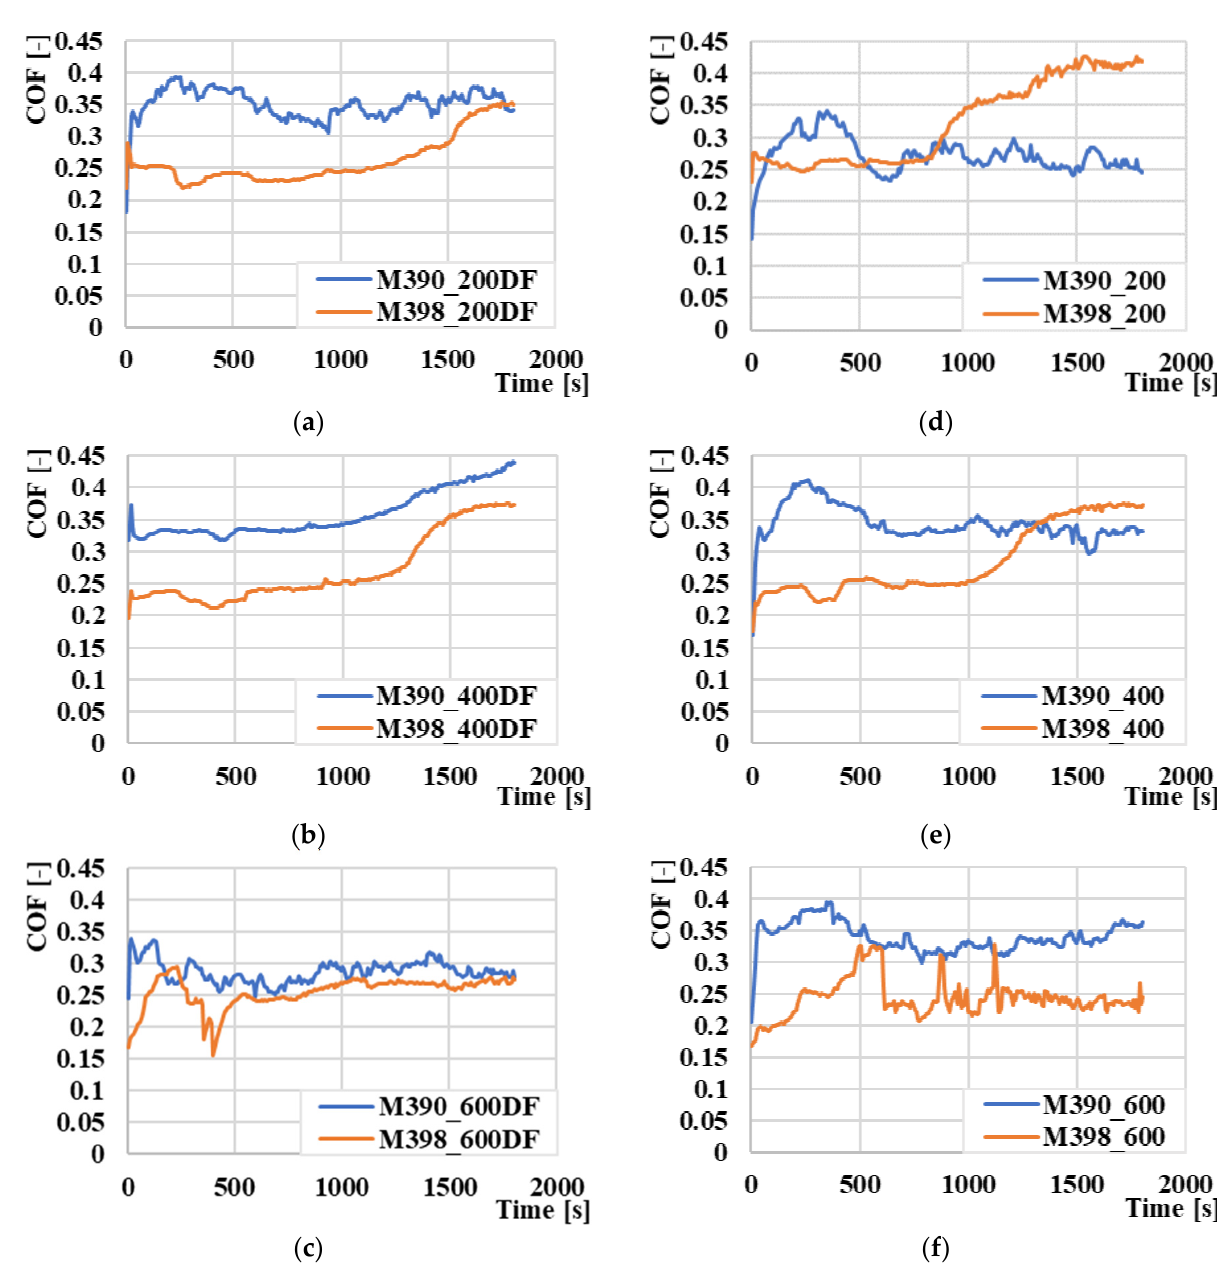
Figure 11. Comparison of the results of the friction coefficient values for: ( a ) M390_200DF and M398_200DF, ( b ) M390_400DF and M398_400DF, ( c ) M390_600DF and M398_600DF, ( d ) M390_200 and M398_200, ( e ) M390_400 and M398_400, and ( f ) M390_600 and M398_600.